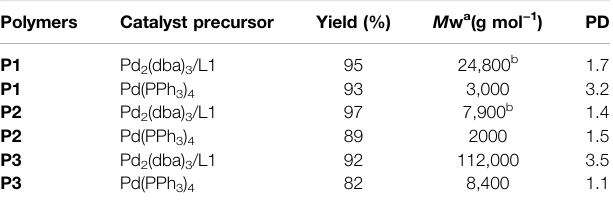
a Molecular weight determined by GPC with THF as the eluent, calibrated with polystyrene standards. b Molecular weight determined by GPC at 150 ° C with 1,2,4-trichlorobenzene as the eluent, calibrated with polystyrene standards.